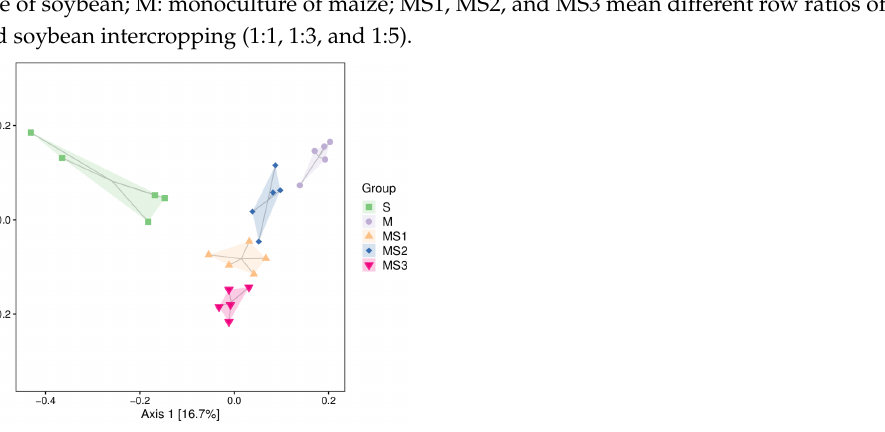
Figure 5. Relative abundance of bacteria at the phylum level ( A ) and genus level ( B ). S: monoculture of soybean; M: monoculture of maize; MS1, MS2, and MS3 mean different row ratios of maize and soybean intercropping (1:1, 1:3, and 1:5).